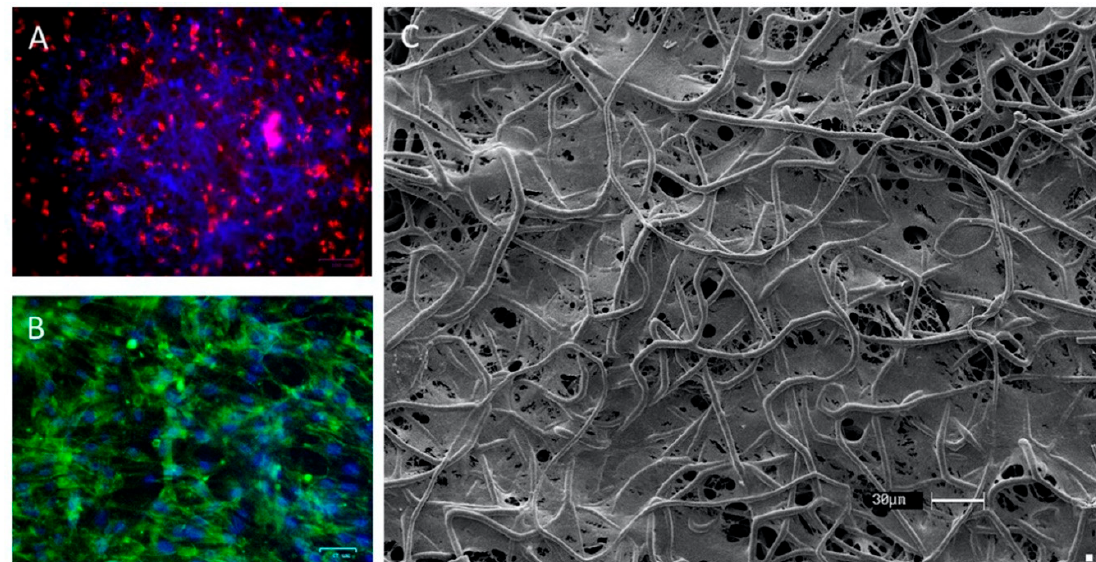
Figure 4. Morphology of culture in the scaffold. ( A ) Fluorescence microscopy of adipose-derived stem cells (ASCs) staining with PKH26 in the first hours of culture in the scaffold; ( B ) fluorescence microscopy of culture of ASC in scaffold staining with phalloidin–FITC; ( C ) Scanning electron microscopy of ASCs on multi-polydioxanone (PDO) scaffold after 14 days of culture.